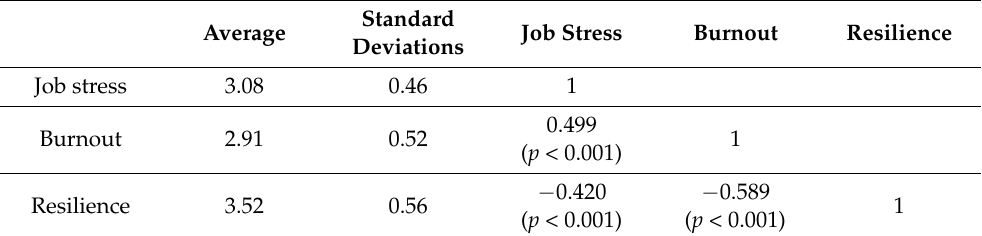
Table 2. Correlation analysis of job stress, burnout and resilience.